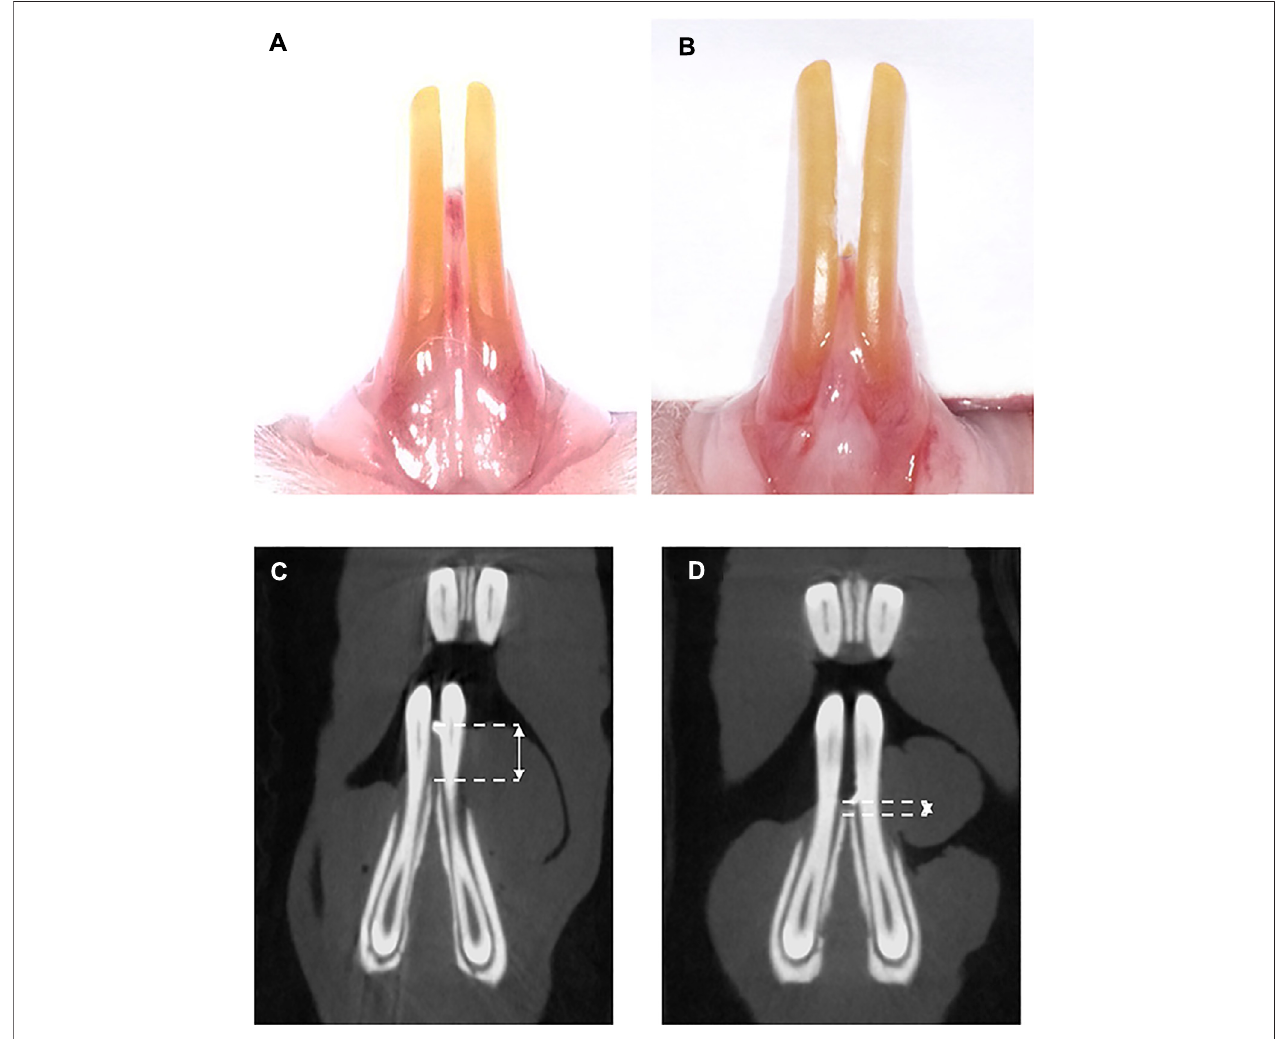
FIGURE 2 | Clinical observations and micro-CT analysis of rat model. (A) Preoperation, (B) 1 week postoperation, (C) micro-CT scanning preoperation, and (D) micro-CT scanning 1 week postoperation. The double-headed arrow shows the distance between the interdental papilla tip and alveolar bone crest.